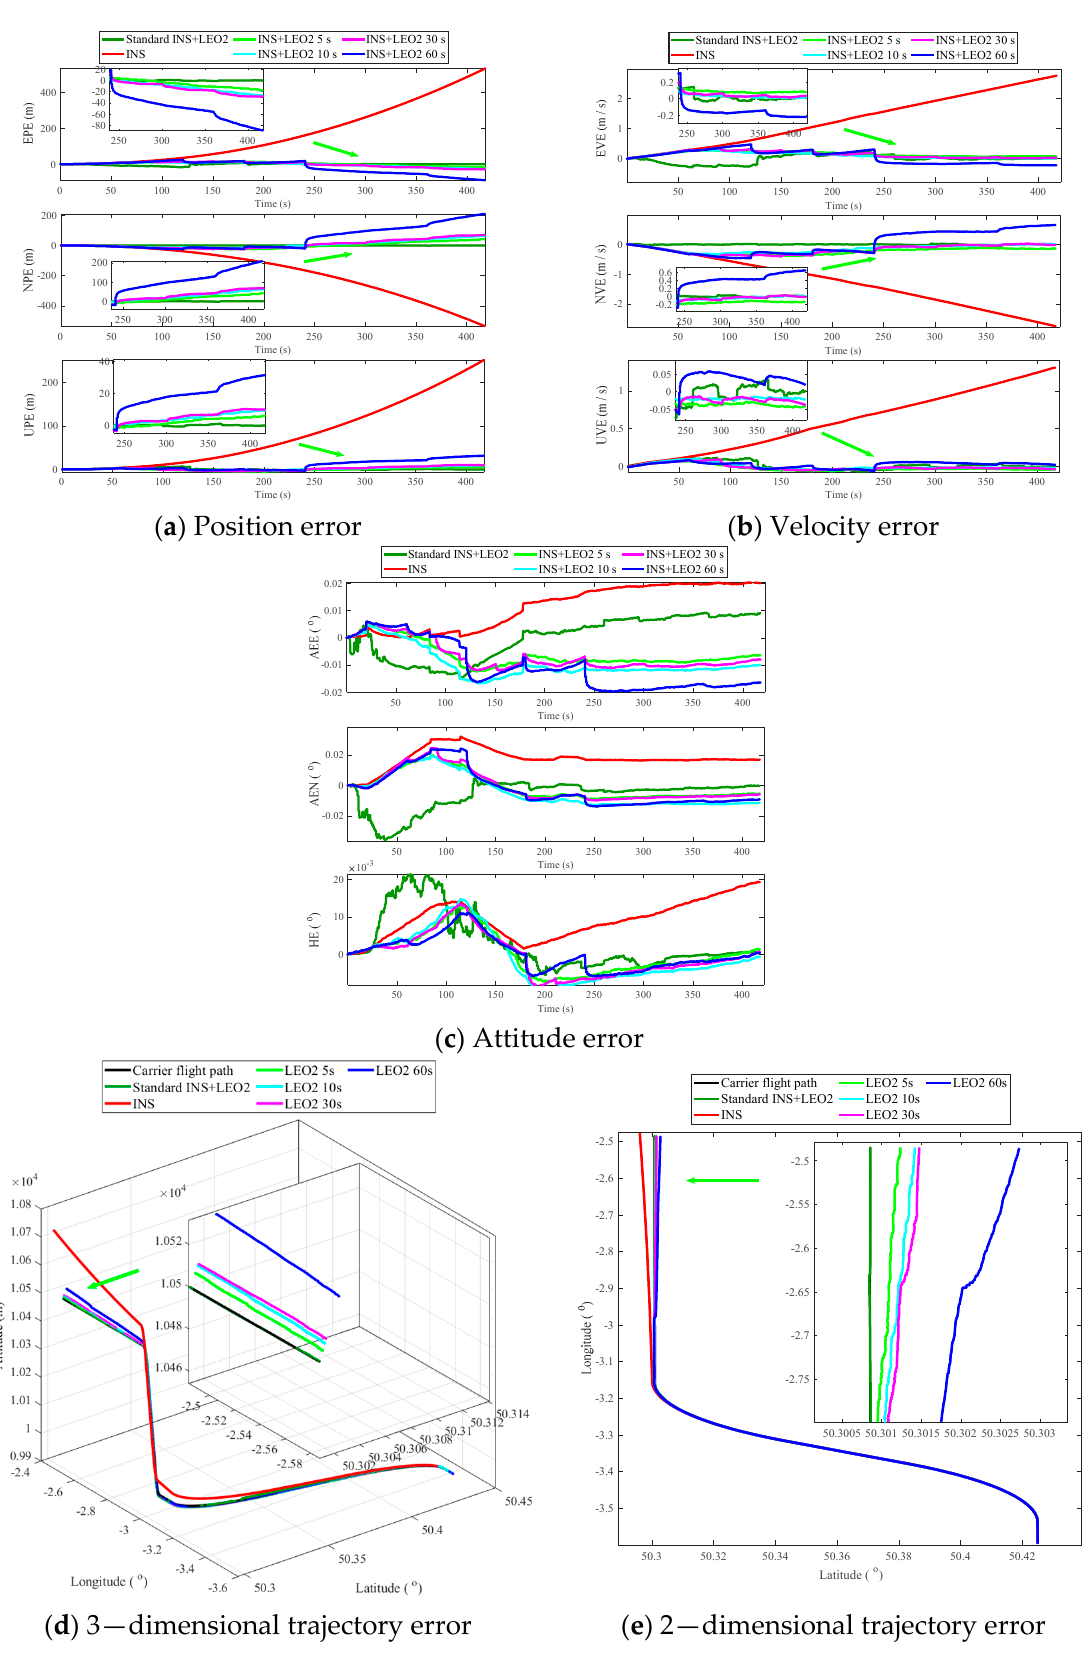
Figure 4. Error curve of the INS+LEO2-satellite alternate switching ranging integrated navigation algorithm based on the same orbital surface.